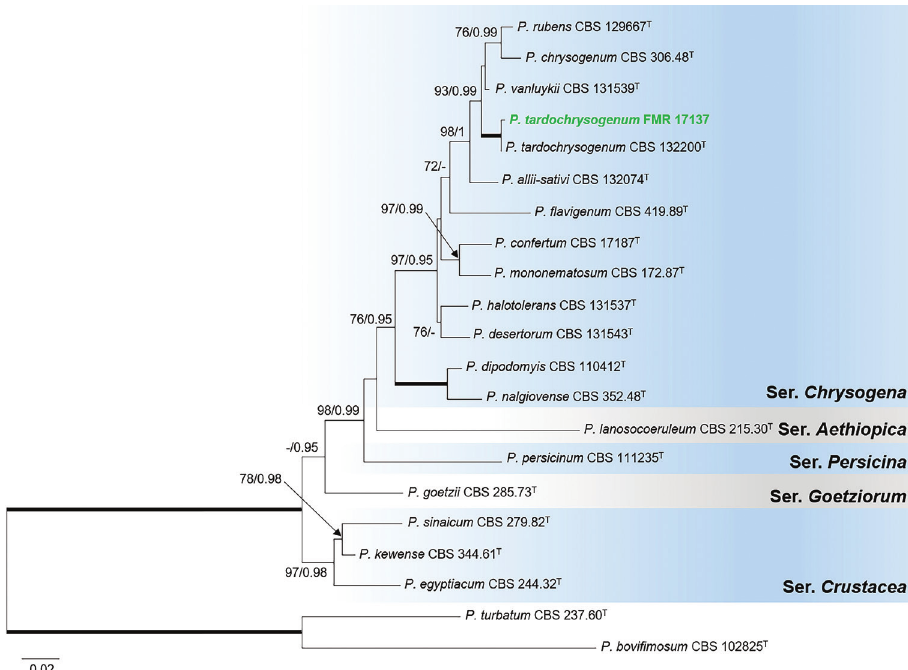
Figure 1. Phylogenetic tree of Penicillium section Chrysogena based on ML analysis obtained by RAxML inferred from the combined tub 2, cmdA and ITS loci. Branch lengths are proportional to phylogenetic distance. Bootstrap support values/Bayesian posterior probability scores above 70%/0.95 are indicated on the nodes. Bold branches indicate bs/pp values 100/1. The tree is rooted to P. turbatum CBS 237.60 and P. bovifimosum CBS 102825. The name in green is the strain of P. tardochrysogenum included in this study. T = Ex-type